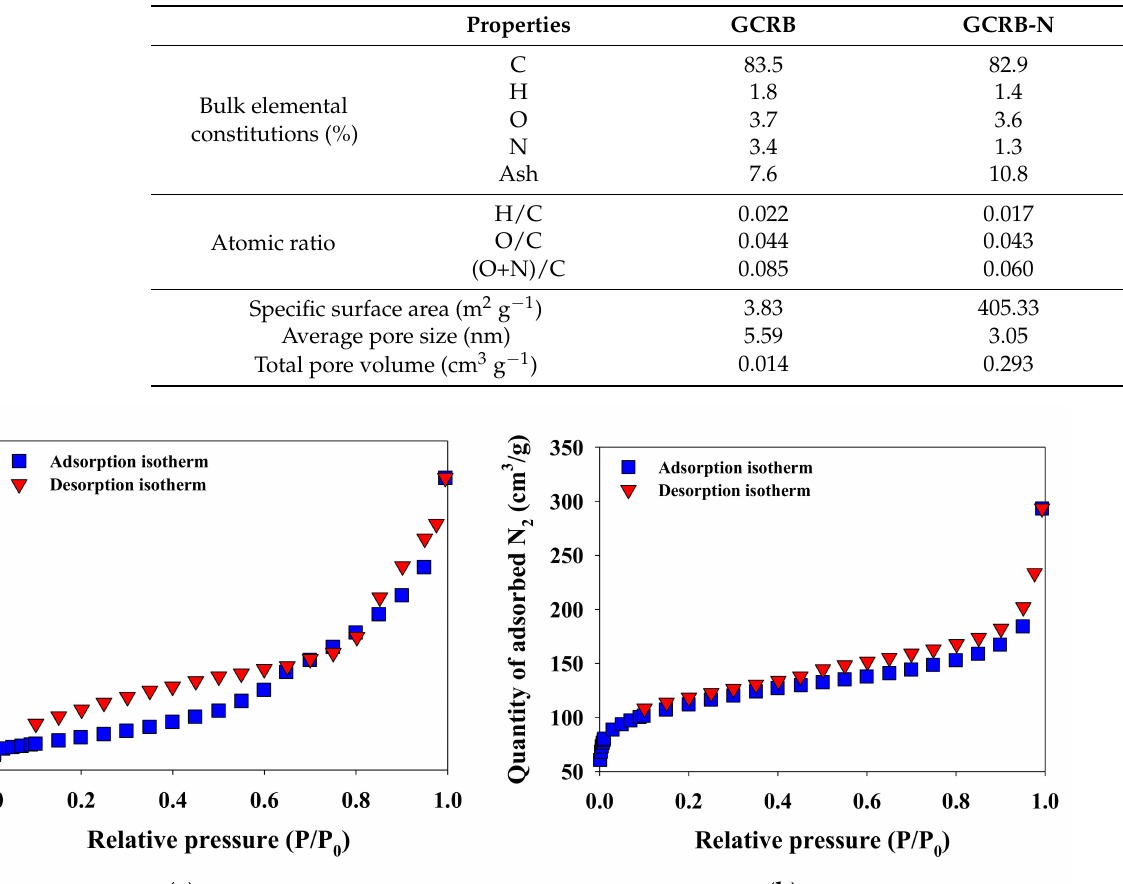
Table 2. The physicochemical properties of the GCRB and GCRB-N.